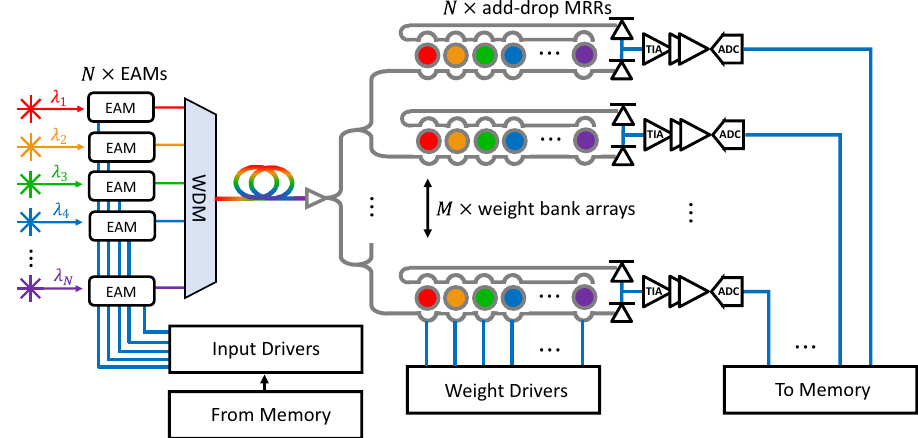
M photonic processing system, where a set of ×